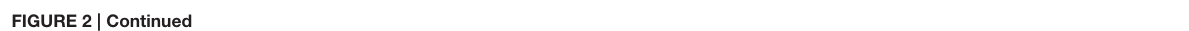
FIGURE 2 | Continued strains expressing PaSod3::Gfp were cultured for 2 d in CM medium. “Free GFP” (indicated by arrow) and PaCYPD were monitored by immunoblotting with anti-GFP and anti-PaCYPD in 100 µ g total protein extracts. The positions of molecular mass markers are indicated on the right. (B) The GFP protein levels of three different isolates of each strain were quantified and normalized to the Coomassie-stained gels (loading control). The protein amount present in the 6 d old wild type was set to one. (C) Monitoring autophagy as described in (A) except using 6 and 11 d old strains expressing PaSod1::Gfp . (D) Quantification of “free GFP” derived from the cytosolic marker PaSOD1::GFP as described in (B) . (E) Growth rate and (F) lifespan of wild type ( n = 20), PaCypD_OEx ( n = 20), ∆ PaAtg1 ( n = 16), and the double